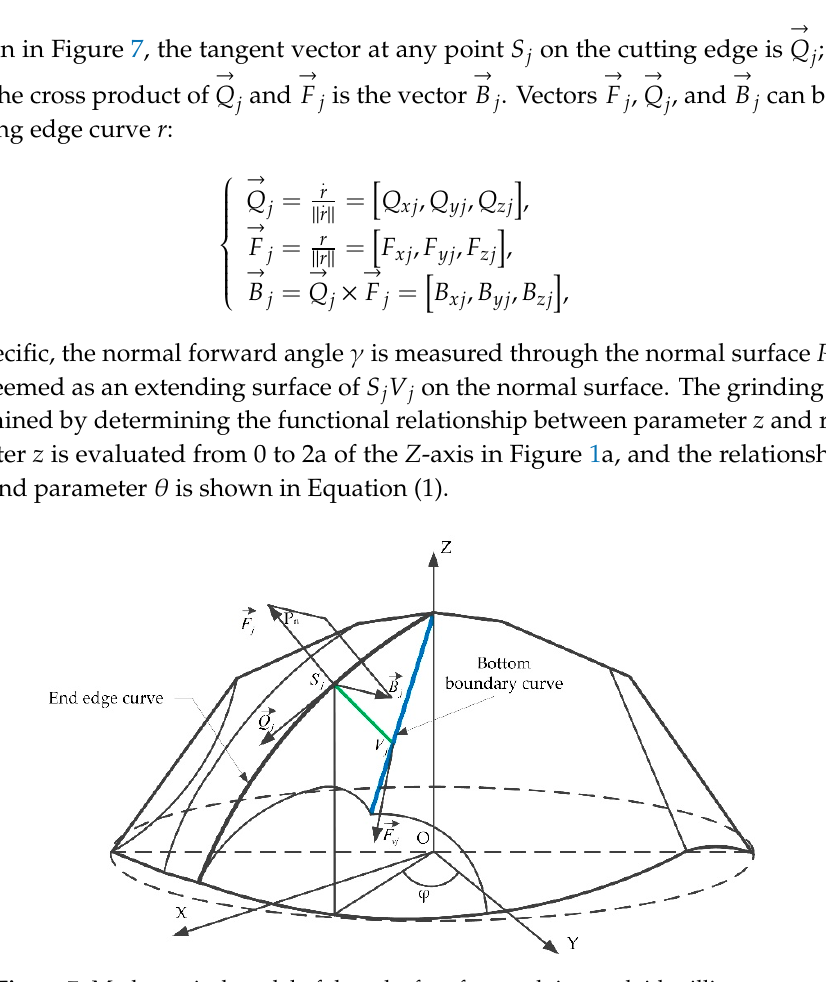
Figure 7. Mathematical model of the rake face for revolving cycloid milling cutter.